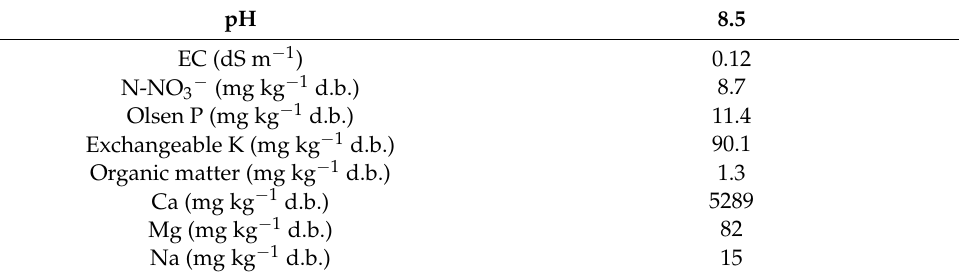
Table 1. Characterization of the soil used for the